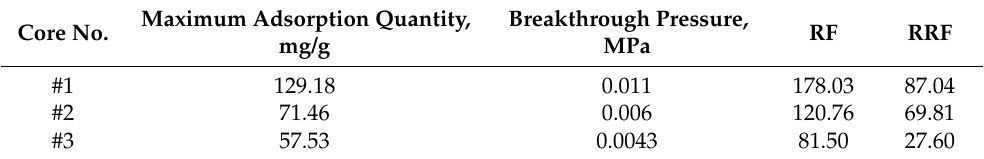
Table 3. Characteristic parameters of gel flooding.